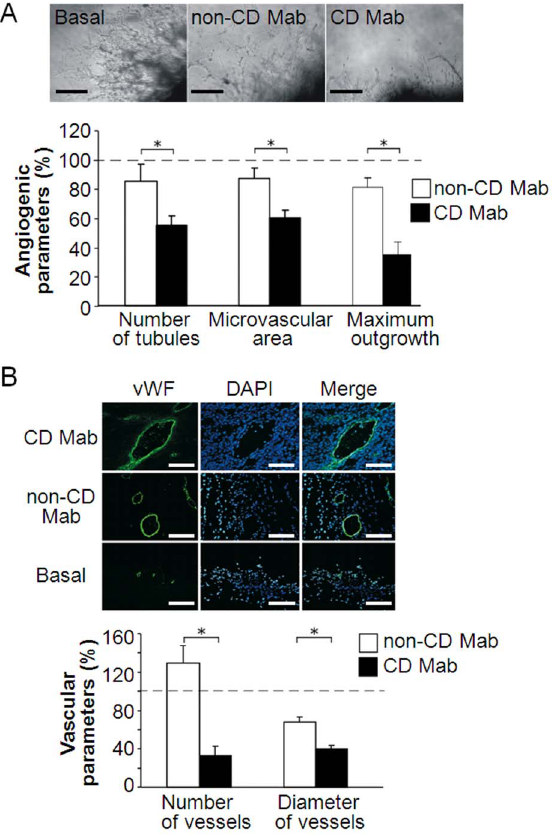
Figure 1. Angiogenesis is impaired exvivo and in vivo after treatment with celiac disease patient monoclonal autoanti- bodies. (A) Representative figures taken from mouse aorta rings cultured inside matrigel for ten days in the presence of monoclonal celiac disease-specific transglutaminase 2 antibody (CD Mab) or its respective control (non-CD Mab). Scale bars represent 100 m m. Bars represent different angiogenic parameters. (n=4 aortas per group). (B) Representative pictures of mouse matrigel implants treated with CD Mab or non-CD Mab. After eight days the implants were removed and stained for blood vessels with von Willebrand factor (vWF)-antibody (green) and blue color indicates nuclei (DAPI). Scale bar represents 200 m m. Bars show vascular parameters measured from matrigel implants. (n=8 animals per group). Bars in both charts, A and B, represent the average value as percentage + SEM. All data was normalized to the basal group (dotted line). * represents P # 0.001 statistical difference.